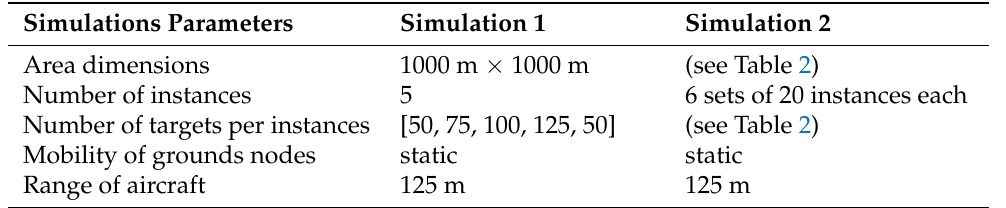
Table 1. Simulation parameters of the two series of experiments.